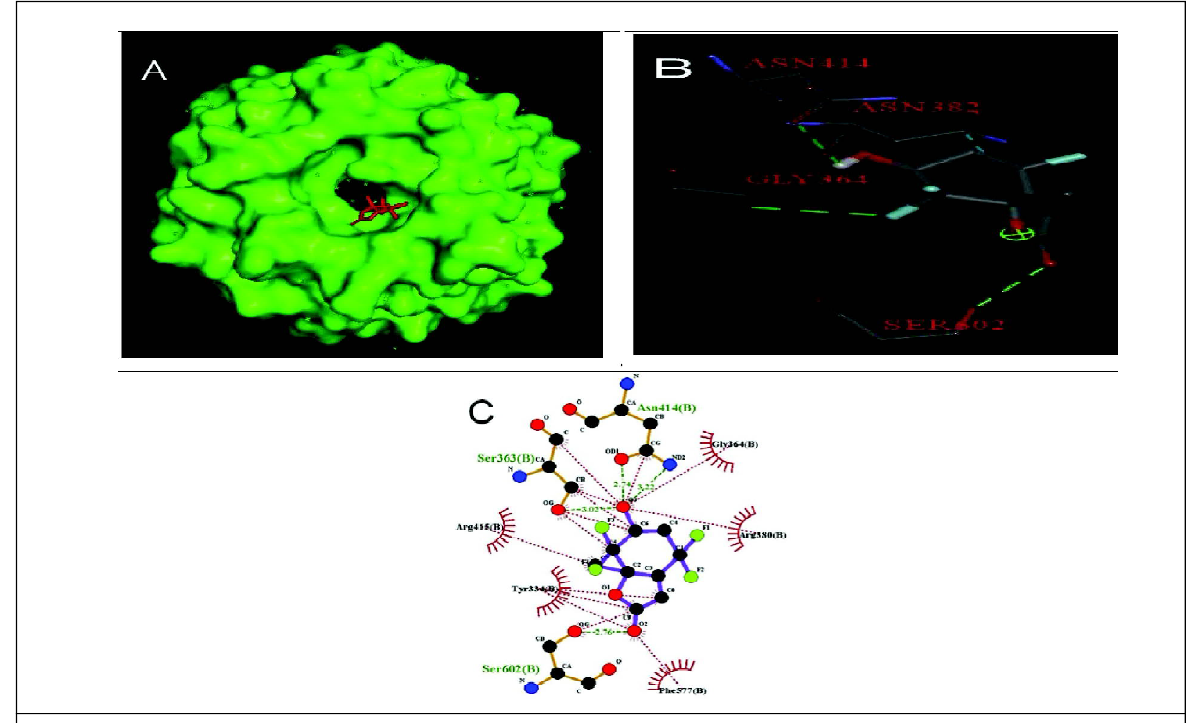
Figure 10: The pictorial illustrations for the Loliolide-5 derivative in the Kelch domain (PDB: 4L7B), including the surface view of the top-ranked docked pose (A), interaction analysis from Accelrys discovery studio (B) and the same from LigPlot (C).